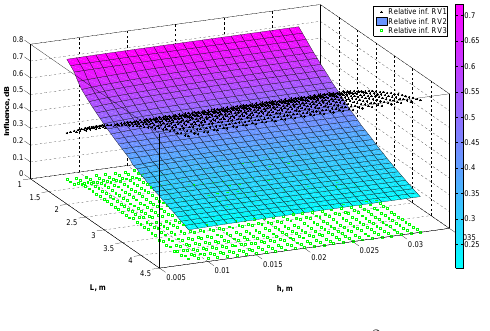
Figure 17: Relative influence criterion ˜ In